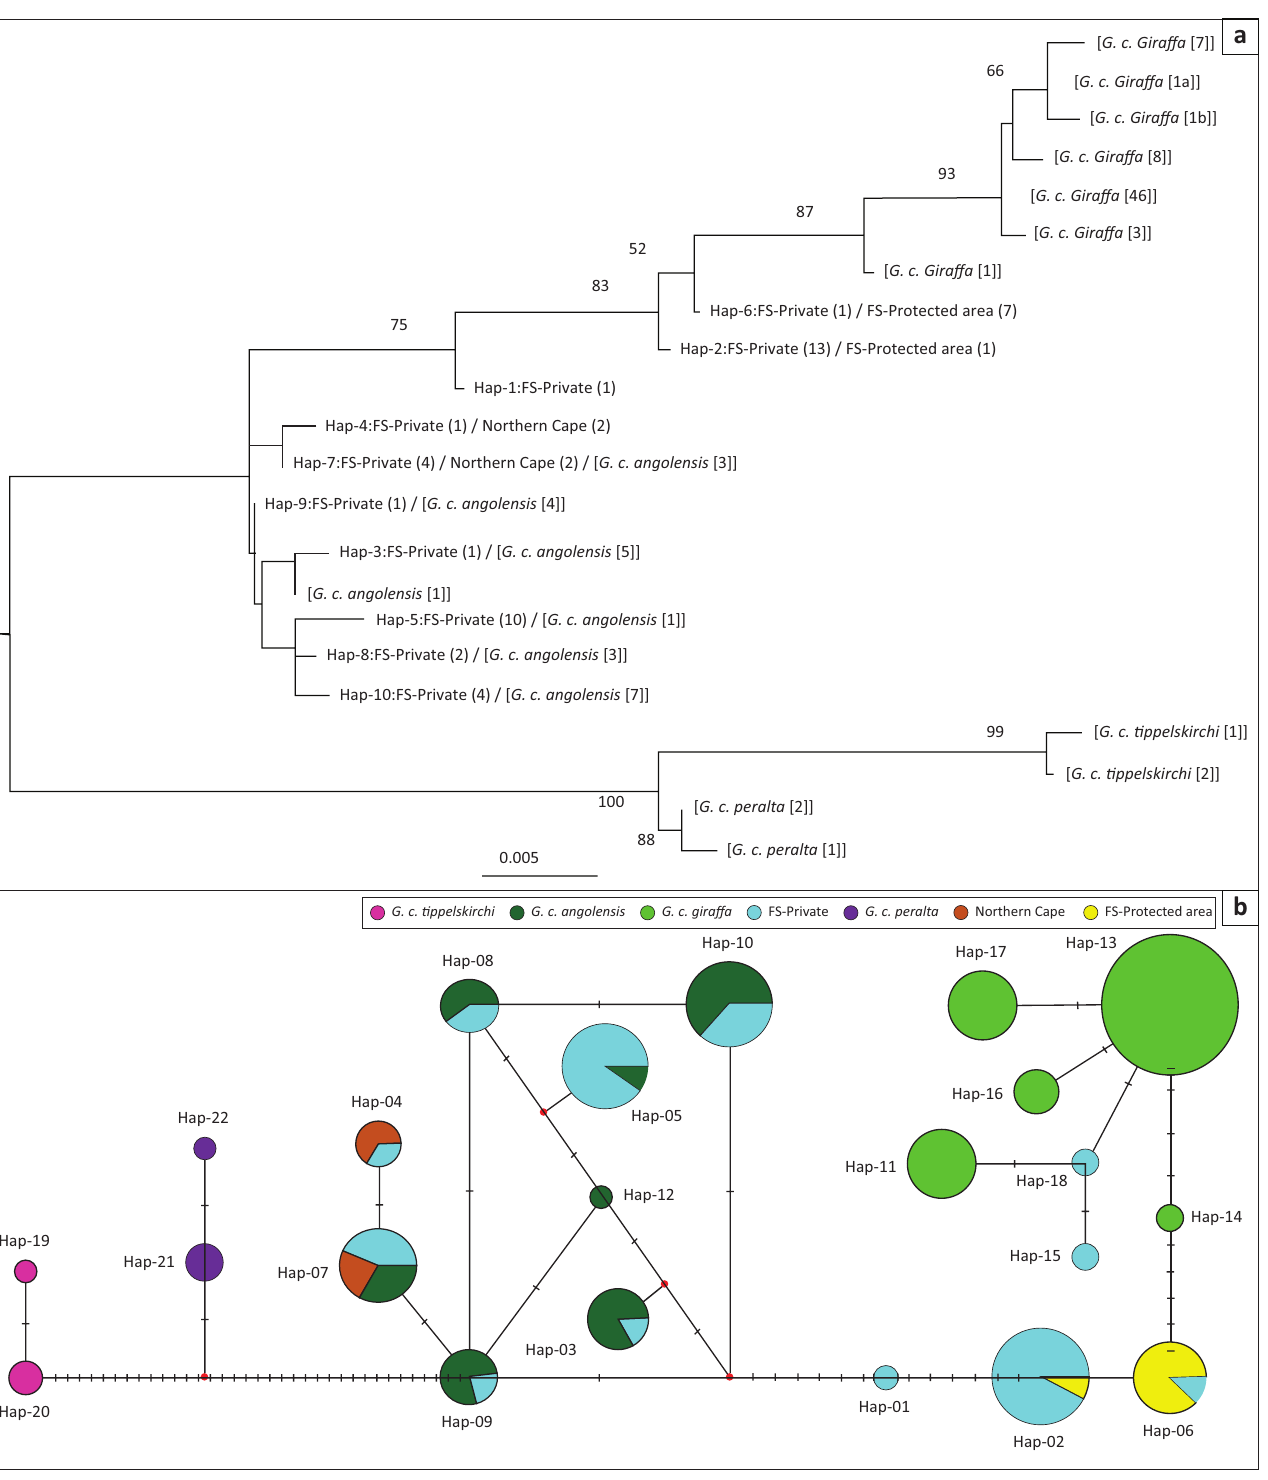
FIGURE 2: Status of giraffe from Central South Africa, relative to reference giraffe populations, based on a concatenated mitochondrial DNA displacement loop (D-loop) and cytochrome b (Cytb) sequence dataset. (a) Phylogeny from maximum likelihood topology of haplotypes. The haplotype names from giraffe analysed for the current study are underlined, with reference samples indicated in [square brackets]. Sample sizes are also indicated. Numbers above branches indicate the percentage of bootstrap replicates where the clade was found. (b) Minimum spanning network. Nodes represent haplotypes, with the size of each node showing the number of individuals that share that haplotype. Crossbars reflect the number of mutational events between specific haplotype G. c. angolensis . The D identity with G. c. angolensis , with D = 0.004, but D between value between the privately owned xy xy xy the Northern Cape group and G. c. giraffa was much higher at giraffes and G. c. giraffa and G. c. angolensis was 0.028 and 0.034, thus equalling the distance between G. c. giraffa and 0.009, respectively.